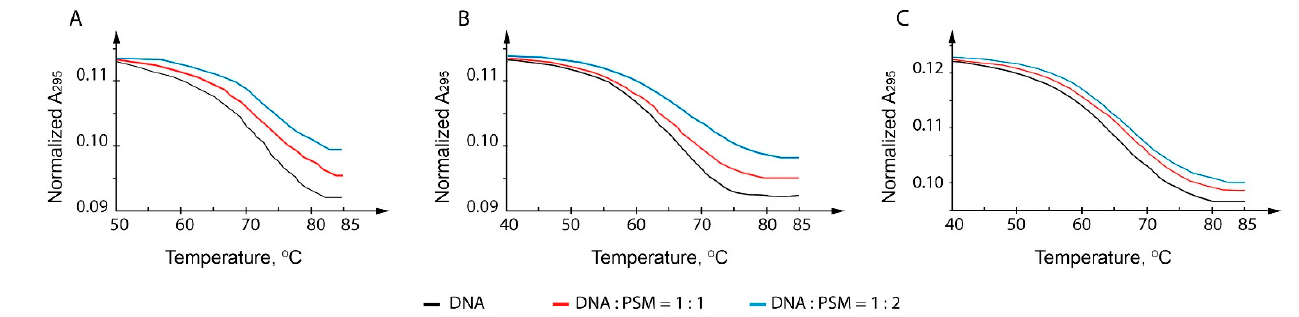
Figure 2. Melting profiles of c-MYC G4 alone ( A – C ) and in the presence of 1 or 2 equivalents of PSMs: sanguinarine ( A , B ) and quercetin ( C ). The temperature dependence of UV absorption was recorded at 295 nm in buffer A ( A ) or buffer B ( B , C ).